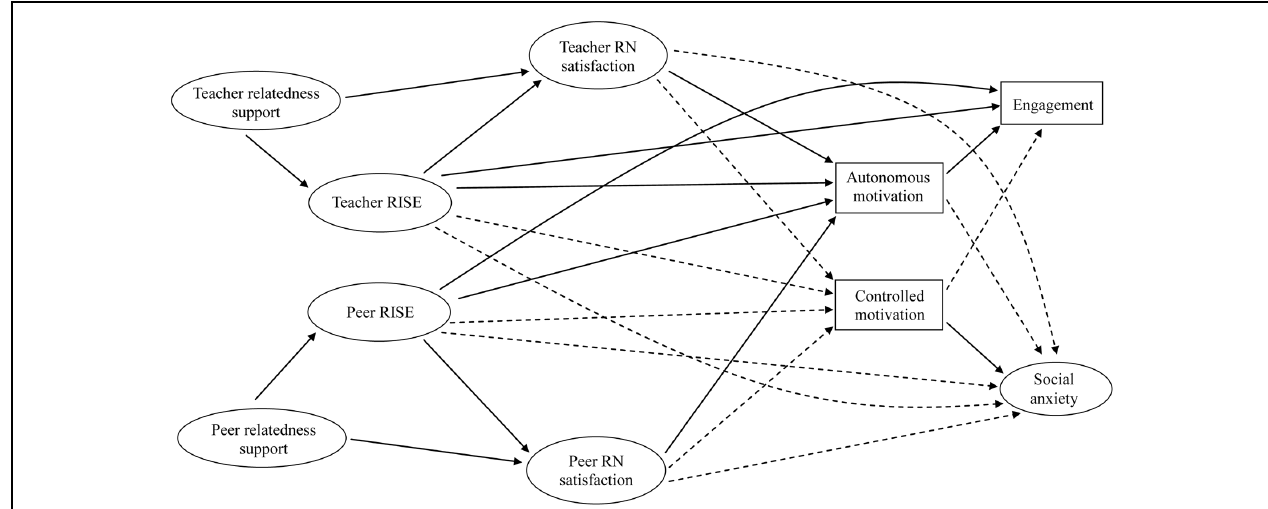
FIGURE 1 | Illustration of proposed structural model. RN satisfaction = relatedness need satisfaction. Solid line indicates pathway was hypothesized to be positive in nature. Dashed line indicates that the relationship was hypothesized to be negative in nature. As is described in the text, in some instances (i.e., RISE → controlled